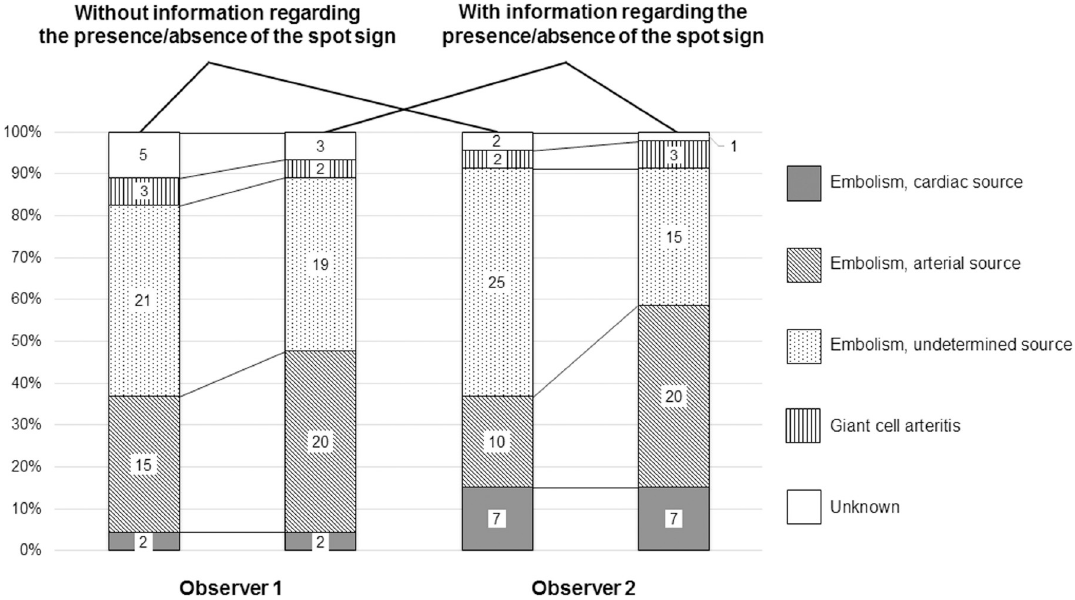
Fig 3. Aetiology of 46 cases with CRAO. Assumed aetiology of 46 cases with CRAO after independent case review by two experienced cardiovascular physicians, with and without the knowledge of the presence or absence of a spot